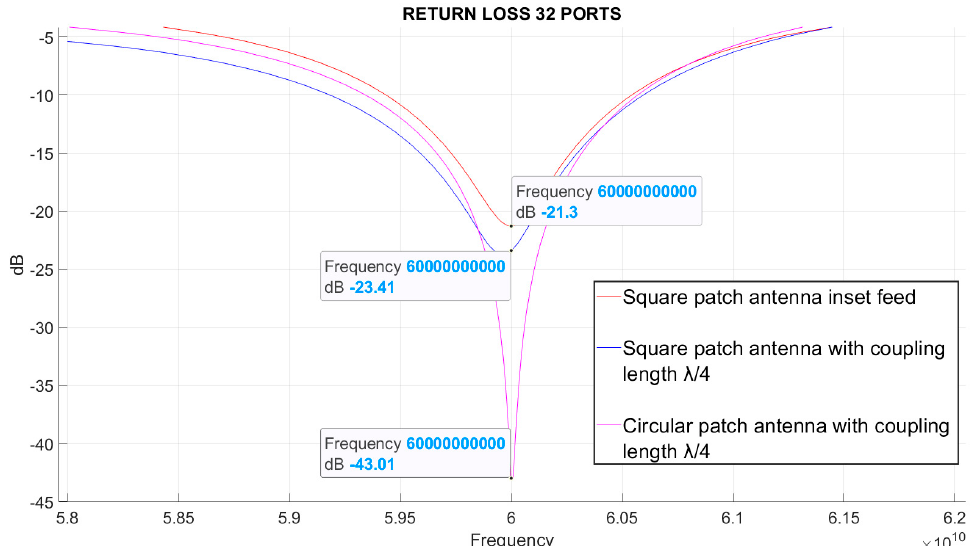
Figure 11. Return loss in antennas with 32 elements.